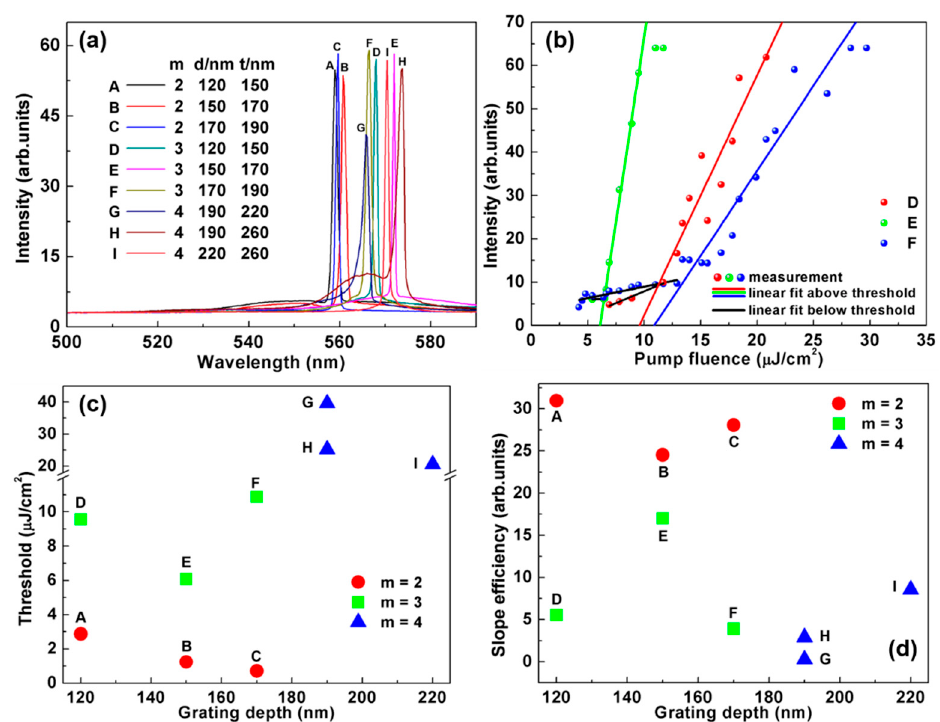
Figure 4. ( a ) Spectra of 9 laser samples; ( b ) measurement points and linear fits for the 3 rd order DFB polymer laser; ( c ) threshold plot for 9 laser samples; and ( d ) slope efficiency plot for 9 laser samples.